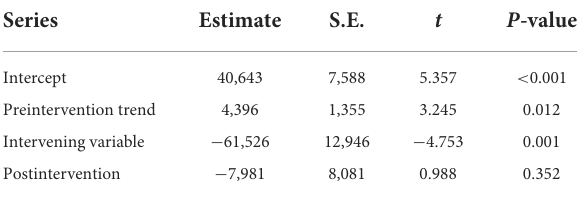
TABLE 5 Correlation of the number of scarlet fever cases with each NPI from January 2011 to May 2022.